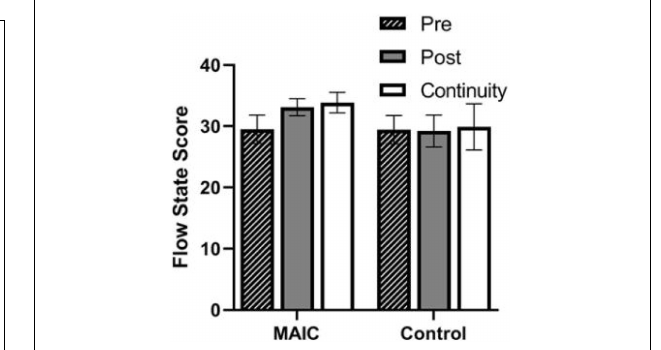
FIGURE 3 | Comparison of flow state scores between MAIC group and control